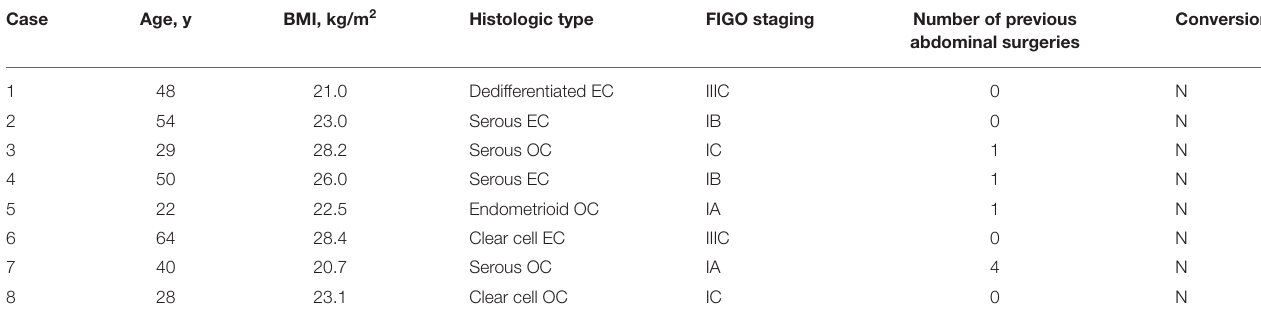
TABLE 1 | Patient characteristics.